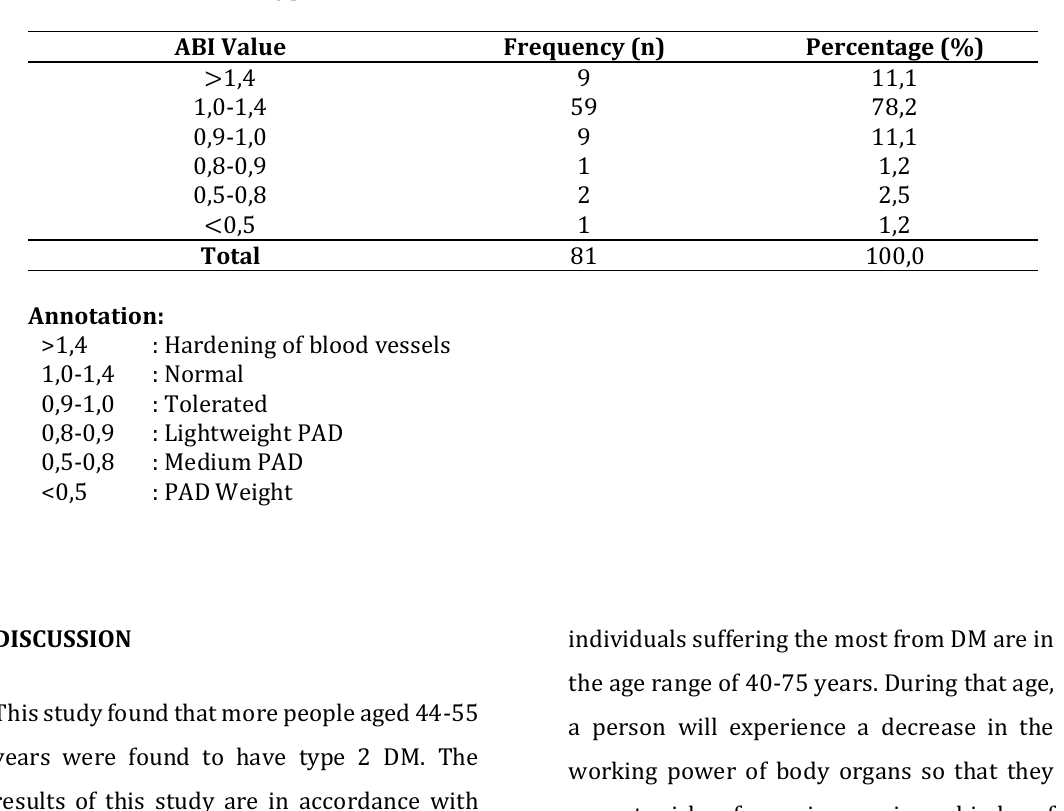
Overview of ABI Score in Type 2 DM